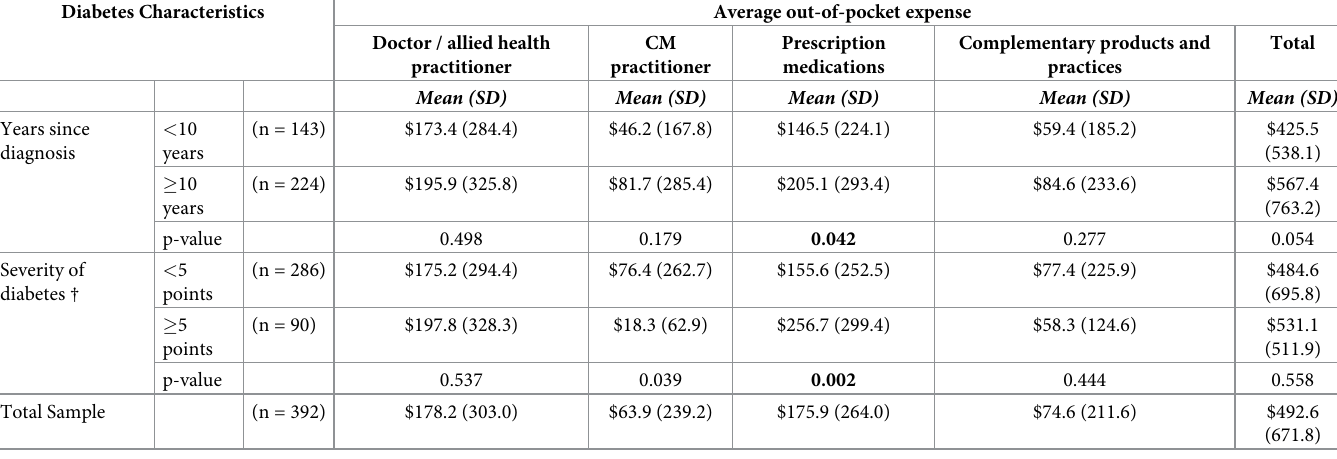
Table 3. Out-of-pocket expenses by years since diagnosis of diabetes and severity of diabetes over the past 12 months. Diabetes